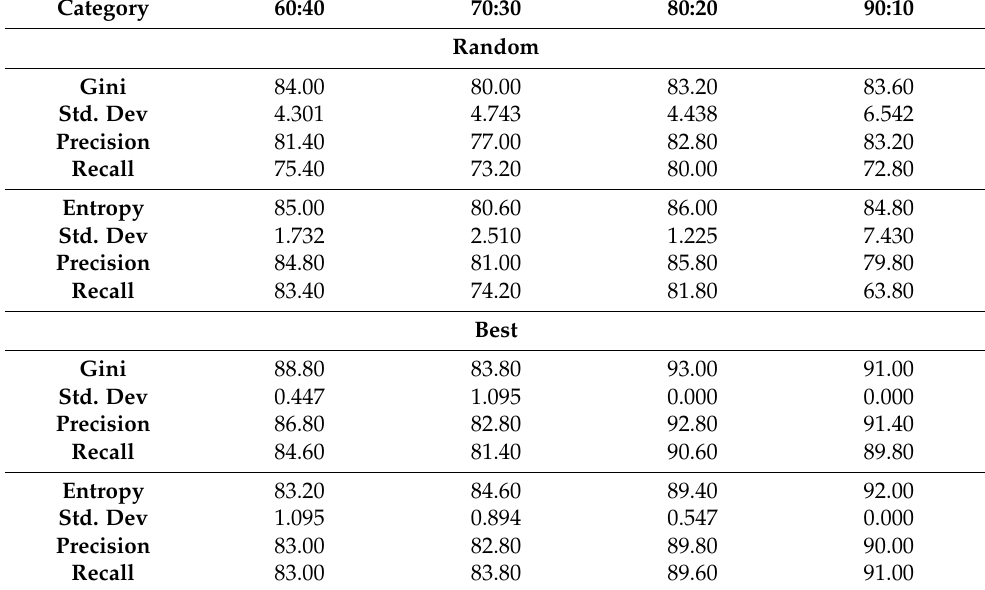
Table 3. Decision Tree Mean Accuracy (Depth =